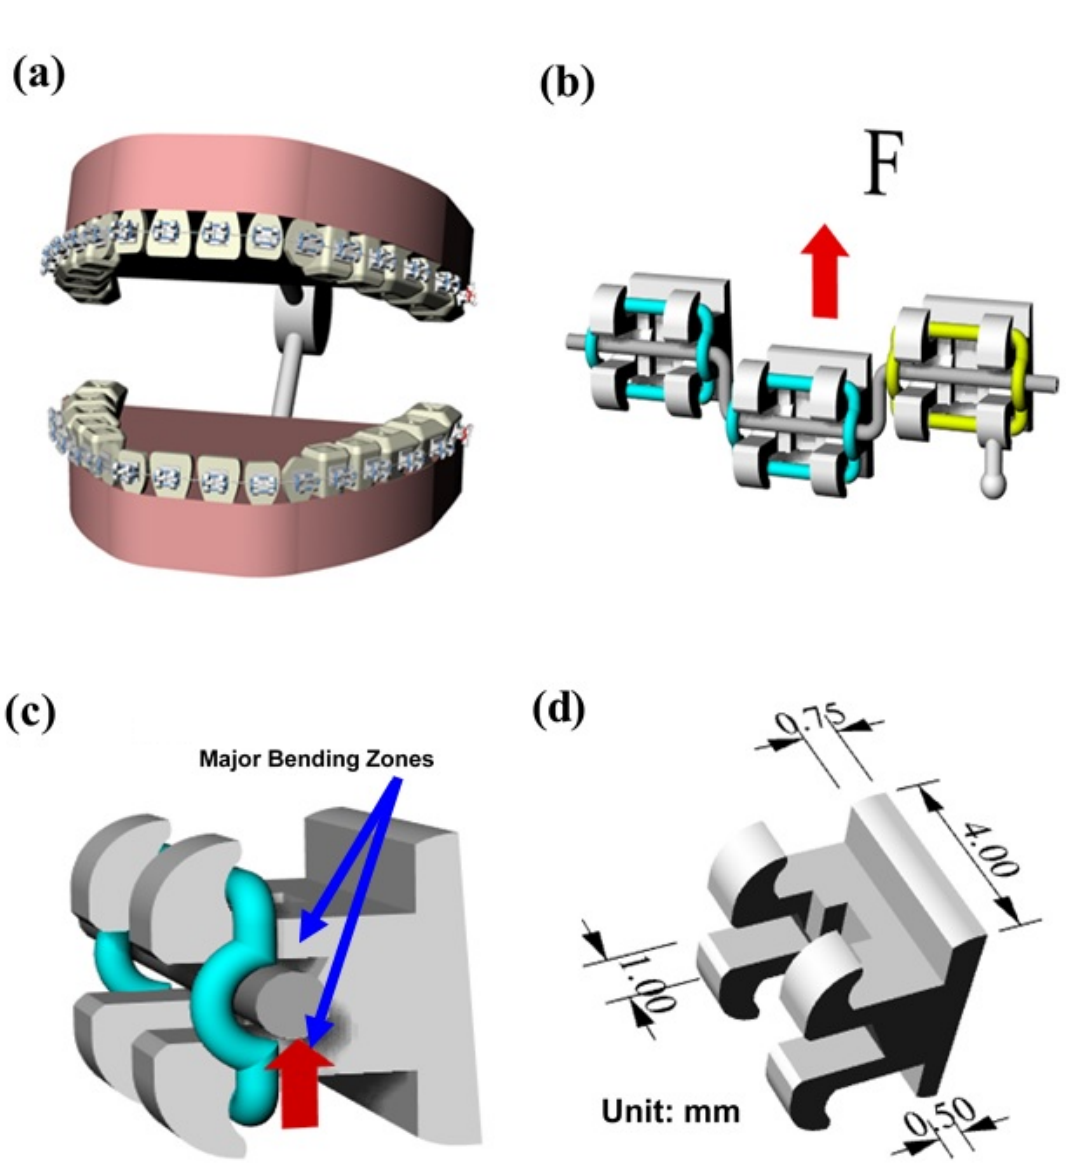
Figure 1. Orthodontic brace for oral correction: ( a ) general arrangement; ( b ) lateral forces acting on cantilever regions of orthodontic brace, ( c ) bending forces acting on cantilever regions of orthodontic brace, and ( d ) geometric dimensions of orthodontic brace.